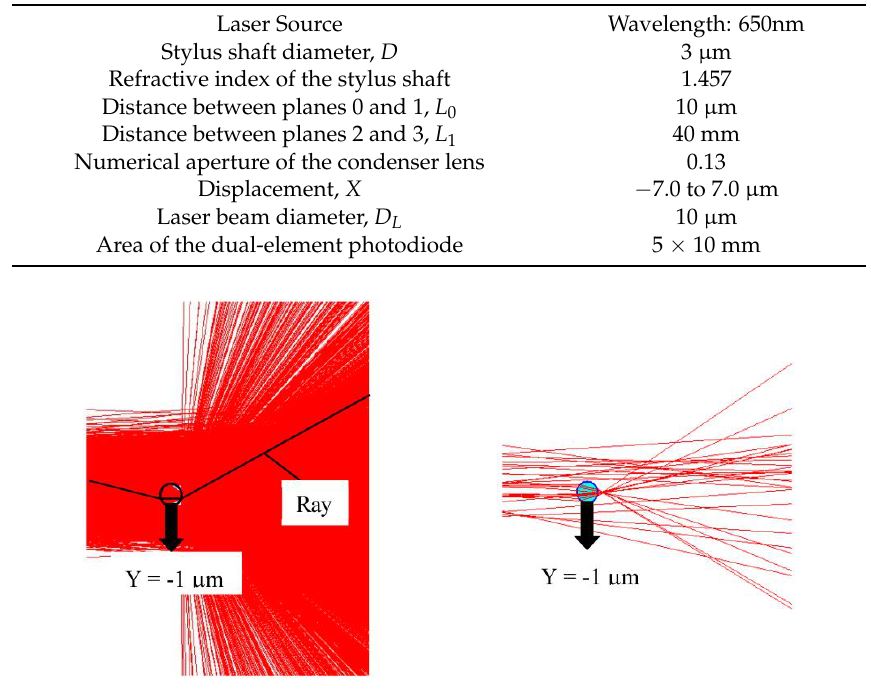
Figure 11. Graphic display of ray tracing (movement of the stylus shaft toward Y = −1 µm); the right figure is obtained by thinning the rays.